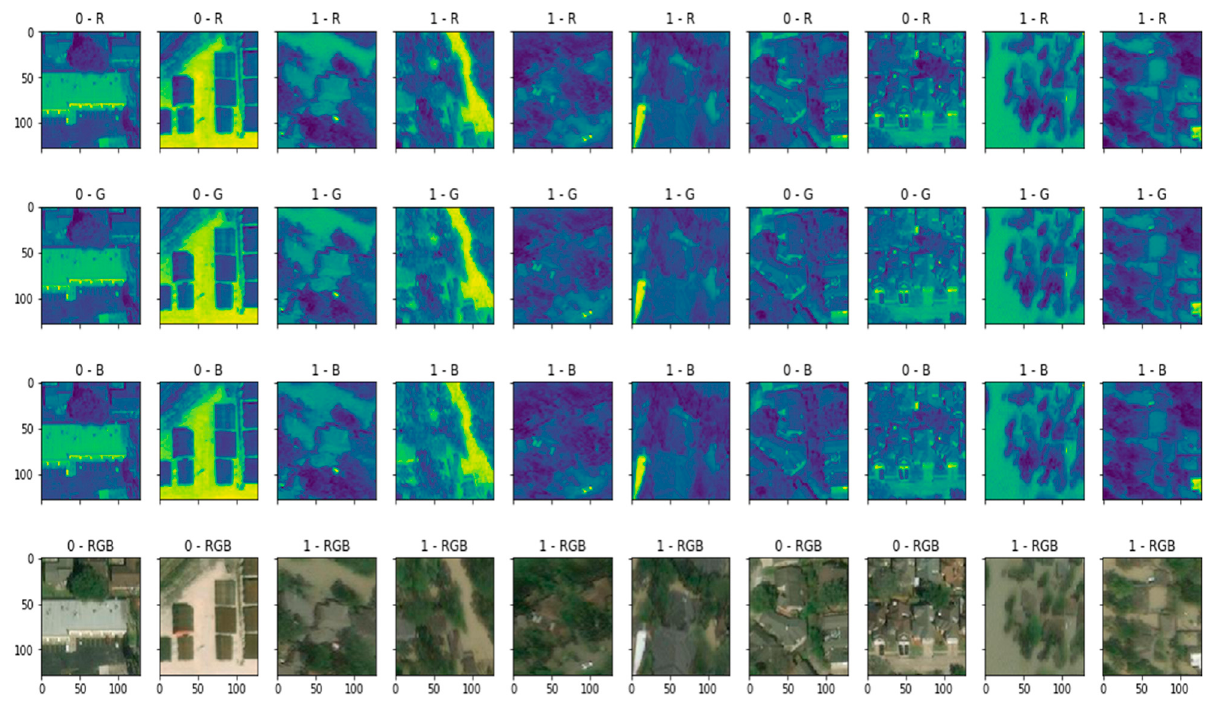
Figure 16. Sample damage/no damage classes read in BGR.